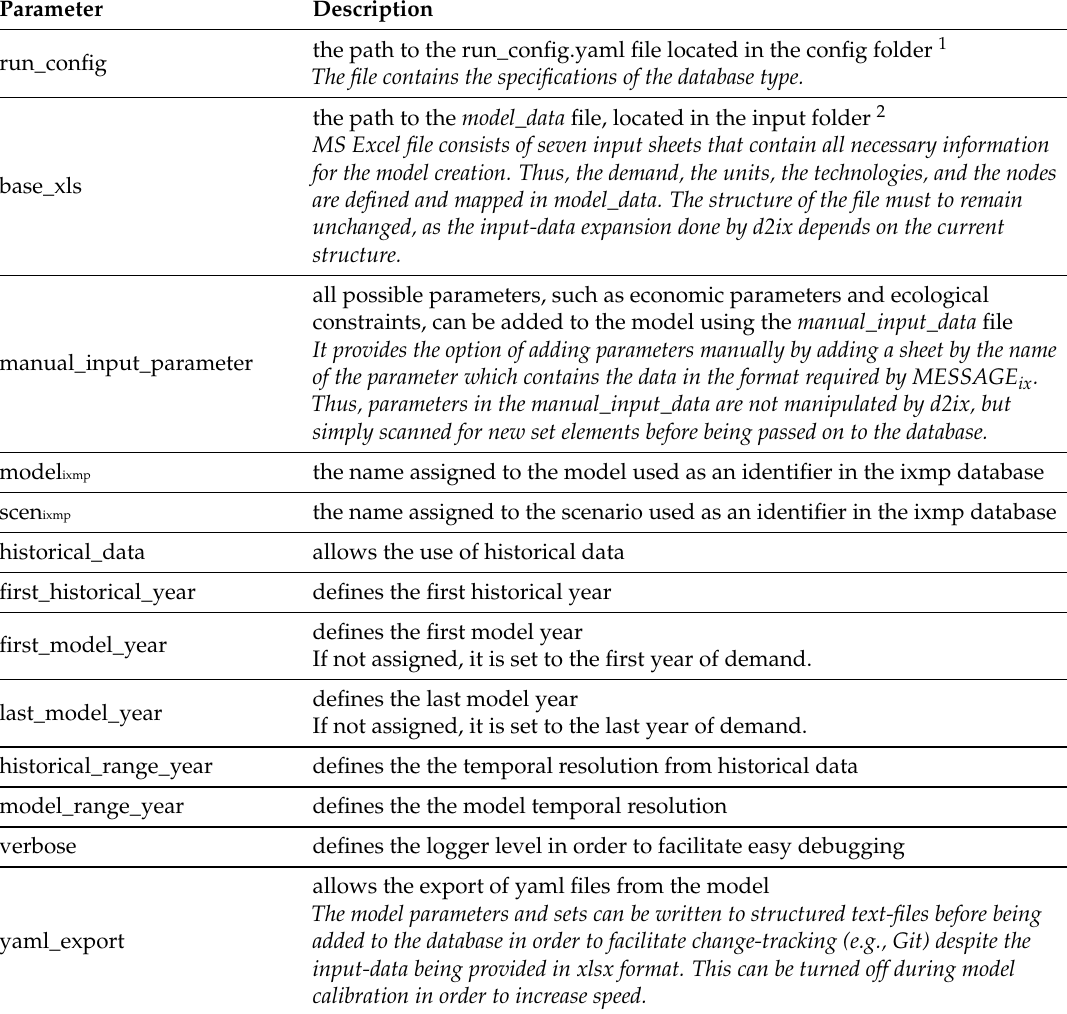
Table 3. Parameters used for creating a model